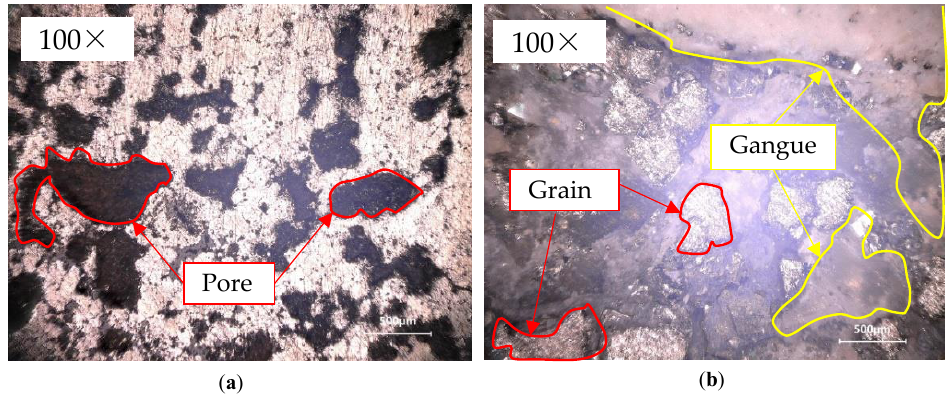
Figure 17. Micrographs of specimens: ( a ) black sample and ( b ) white sample.